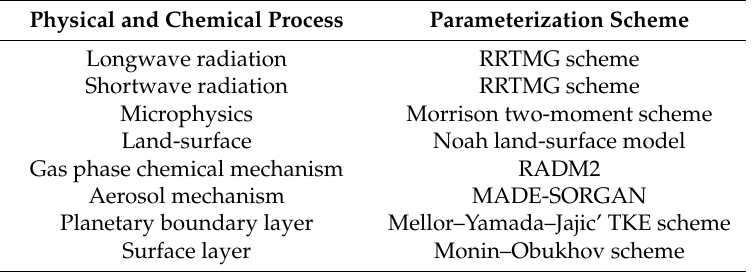
Table 1. Configurations of the physical and chemical schemes of the WRF-Chem